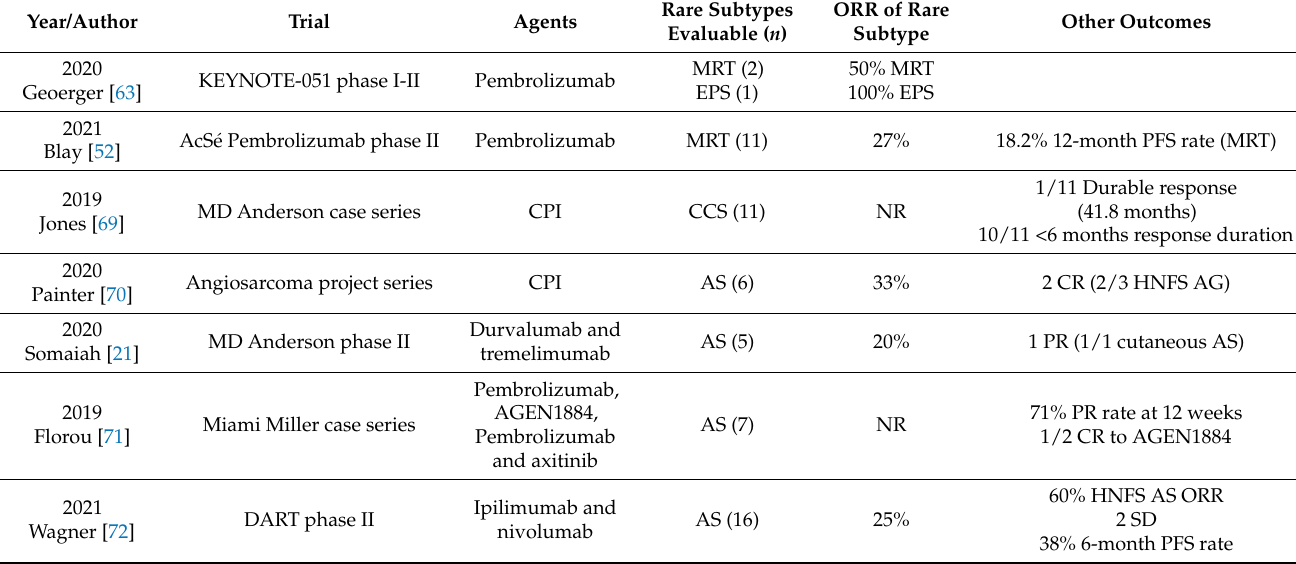
Table 3. Clinical trials and reports exploring the use of CPIs in SWI/SNF-deficient sarcomas, clear cell sarcomas and